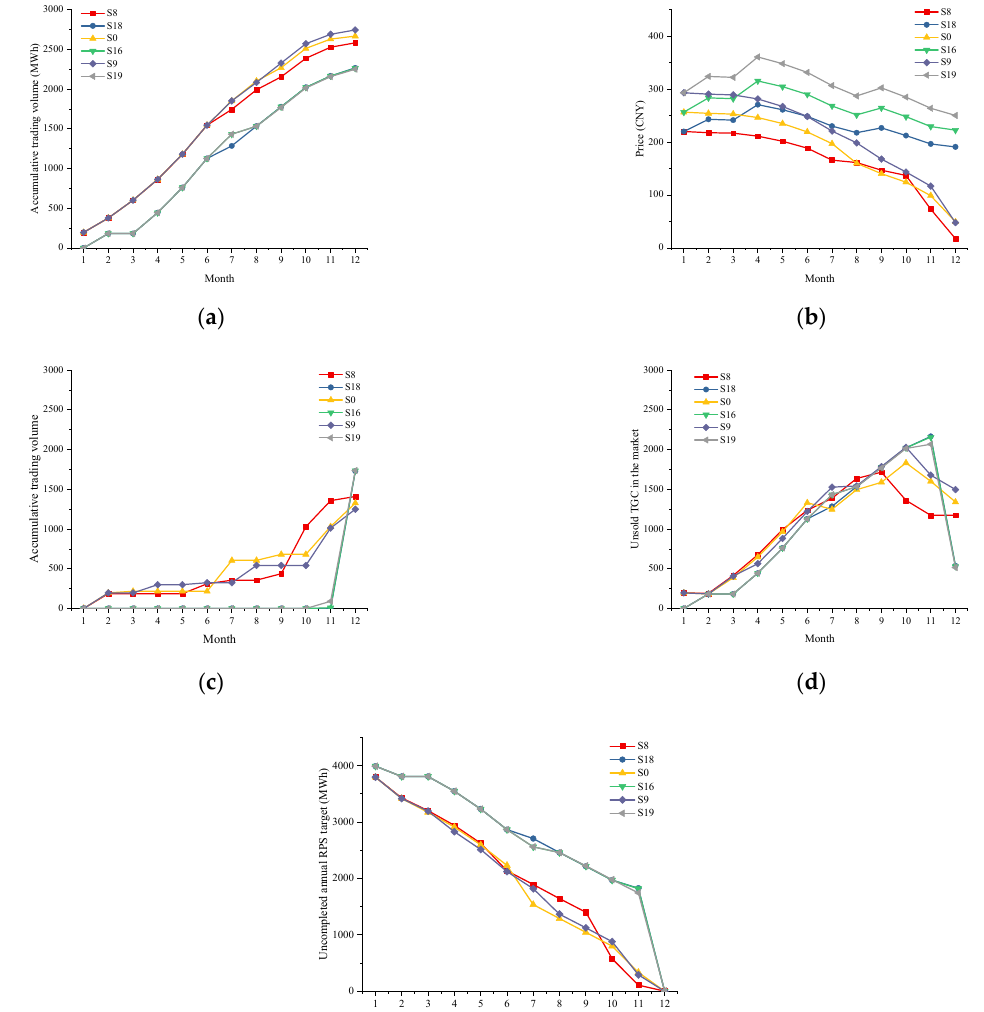
Figure 12. Trends of decision-making and market performance under different discount factors and TGC price caps. ( a ) Accumulative renewable-power trading volume. ( b ) TGC price. ( c ) Accumulative TGC trading volume. ( d ) Accumulative unsold TGCs. ( e ) RPS target